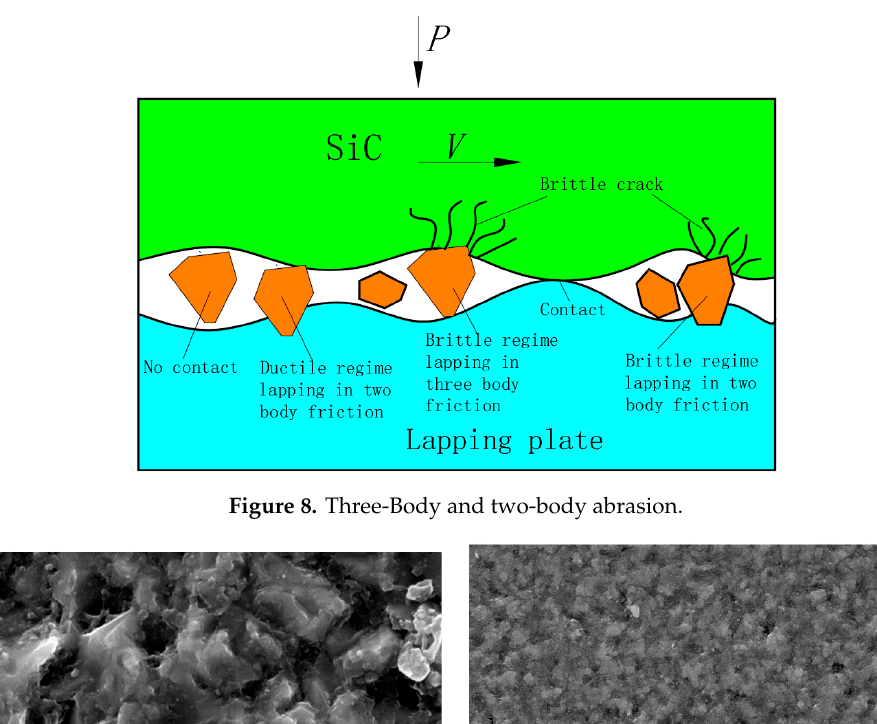
Figure 8. Three-Body and two-body abrasion.